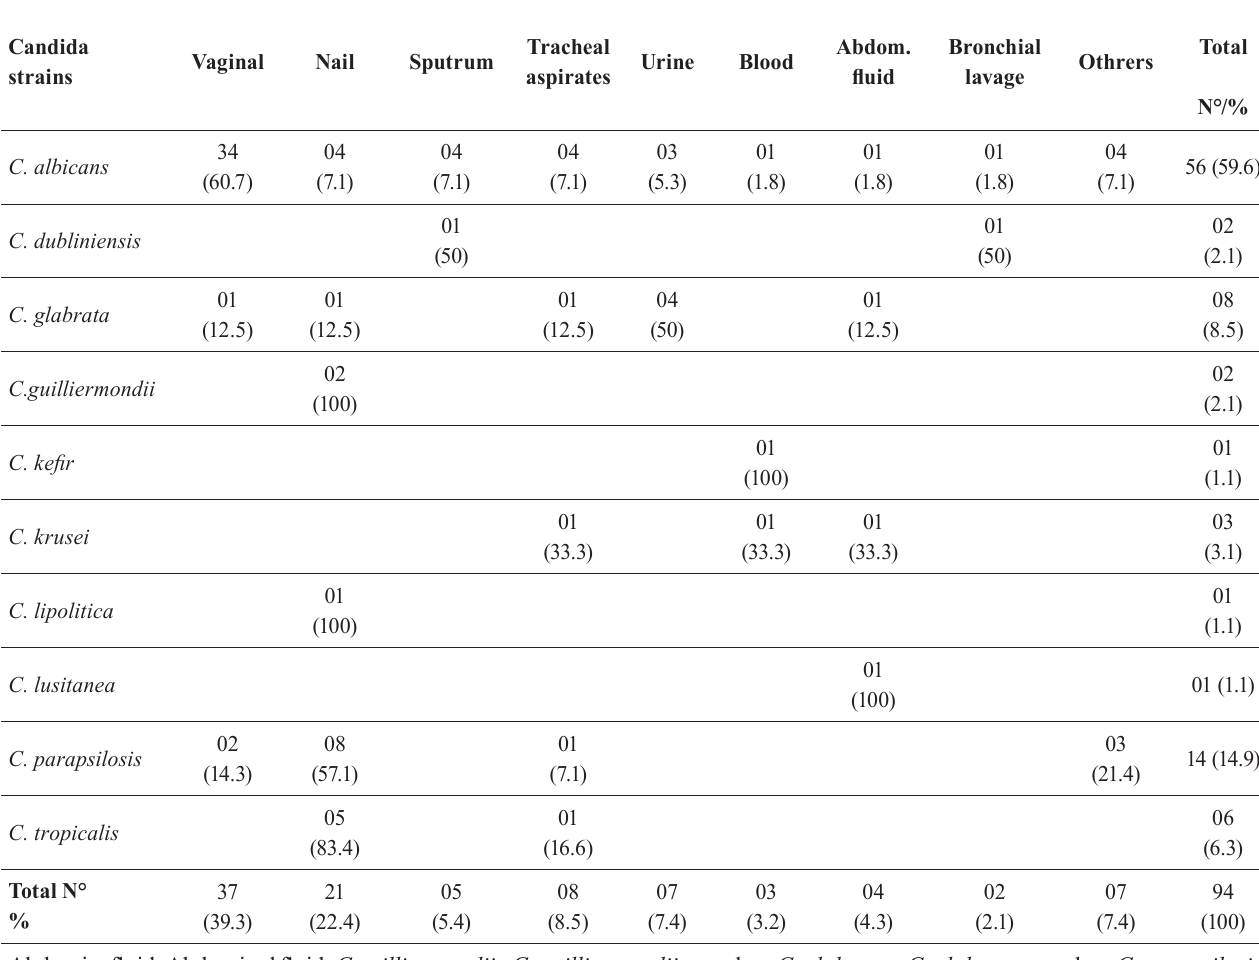
Table I – D istribution of Candida isolates according to the clinical isolation sites